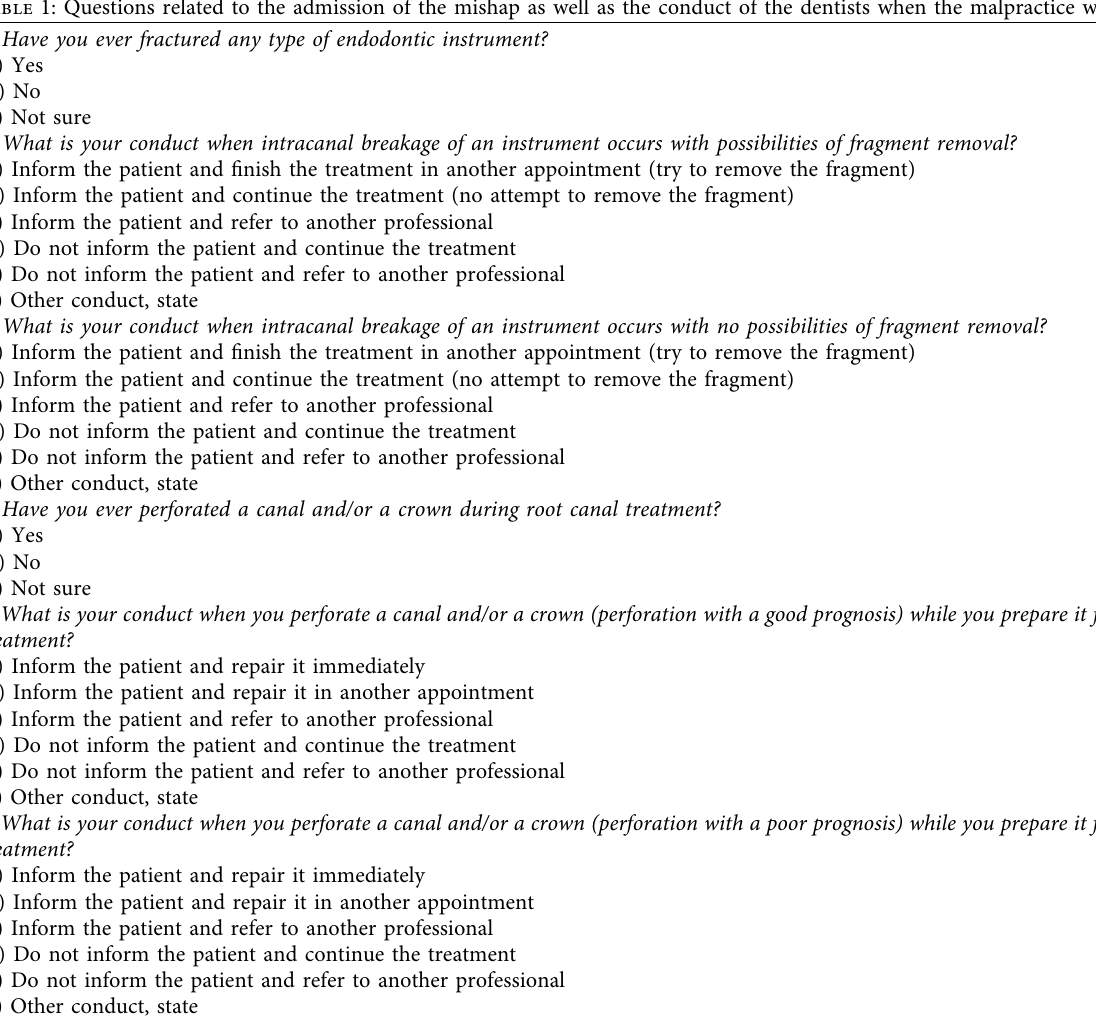
Table 1: Questions related to the admission of the mishap as well as the conduct of the dentists when the malpractice was perceived.